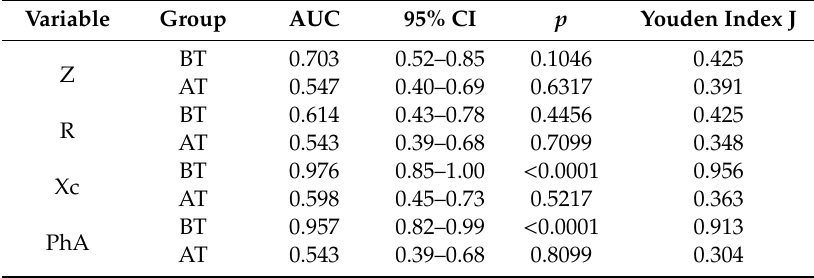
Table 6. Characteristics of receiver operating characteristics (ROC) curves of BIA variables in Beginner and Advanced groups.